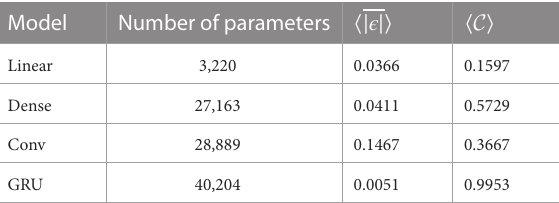
TABLE1 NeuralNetworkArchitectureComparison.Performance comparisonfordifferentarchitecturesofourmachinelearning-based emulator.Asametric,weusedthemeanabsoluteerror | ϵ | (lessisbetter) andanormalizedcorrelation C (closertooneisbetter),bothaveraged overallspatialgridpoints,alltimestep,andallavailabletestcases.